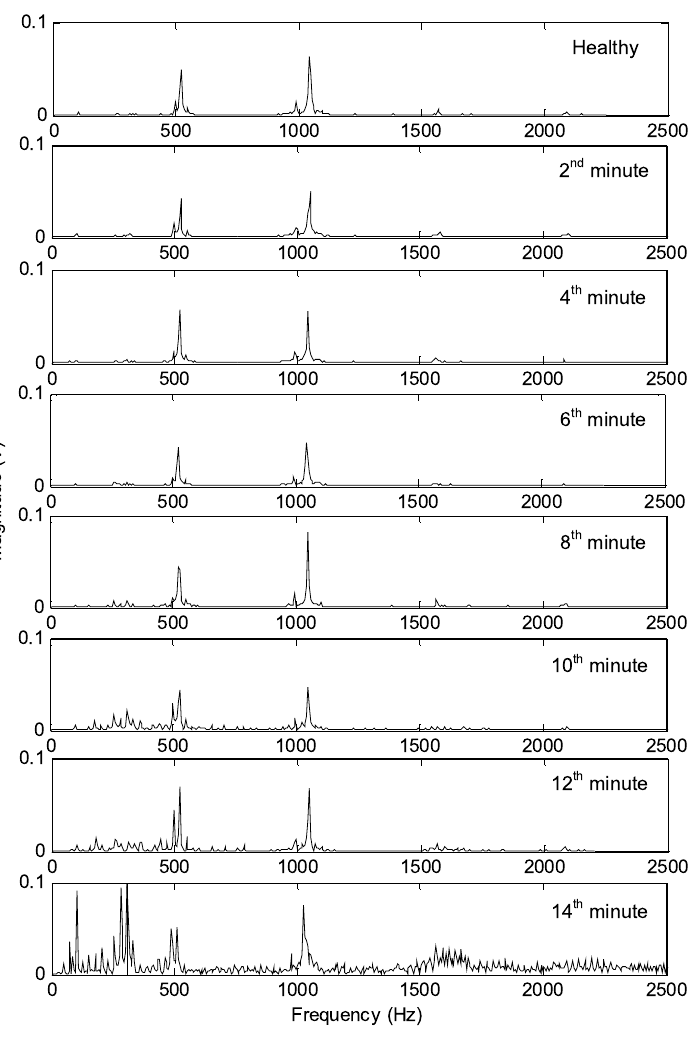
Fig. 8. Spectra of the gear vibrations monitored at two-minute intervals during the fatigue